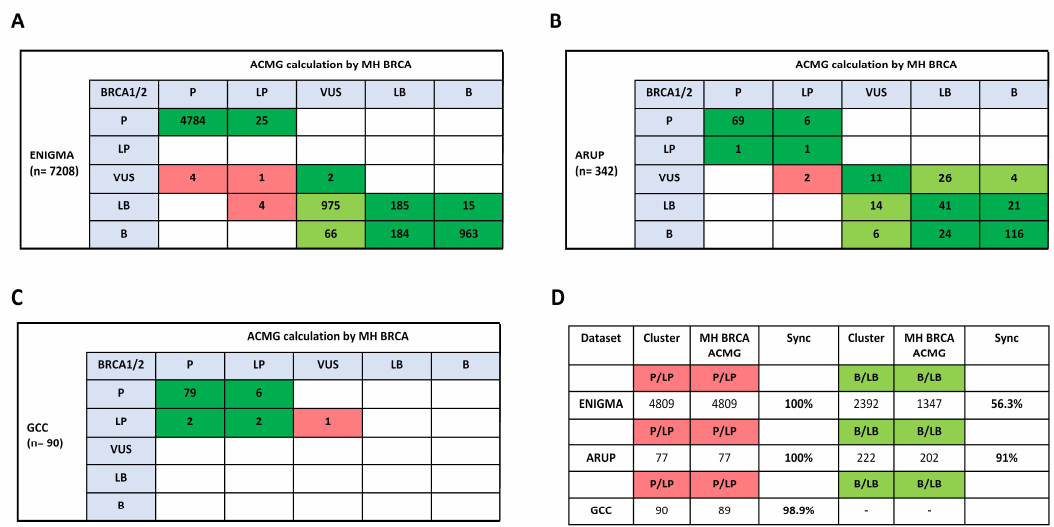
Figure 3. Comparison to ClinVar submitter content for BRCA1/2 variant classification.